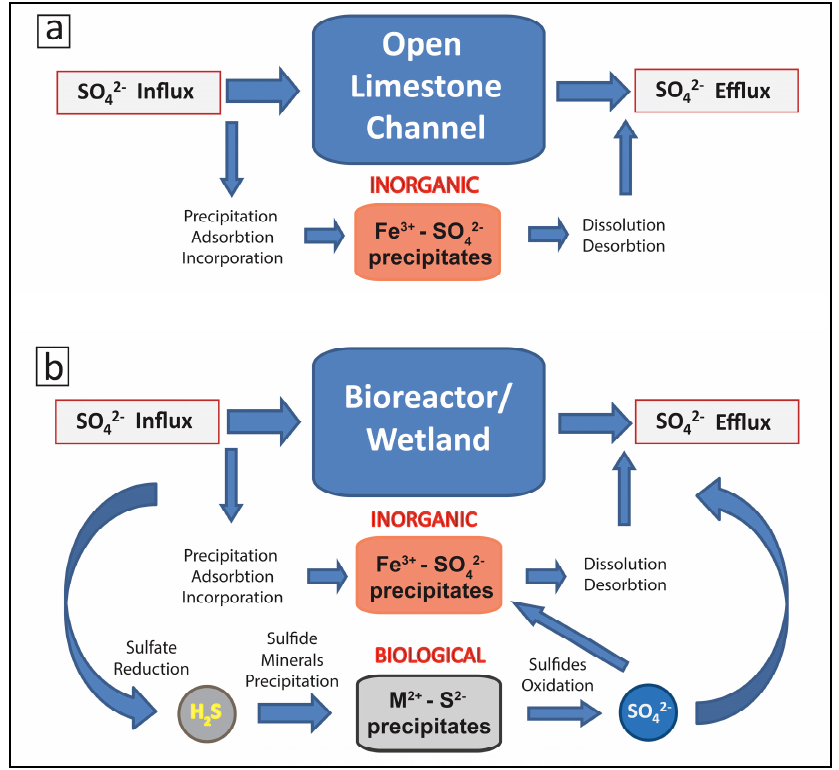
Figure 2. Simplified sulfur cycling and sequestration in a typical passive bioremediation system components: ( a ) the open limestone channel; and ( b ) the bioreactor and/or the wetland.